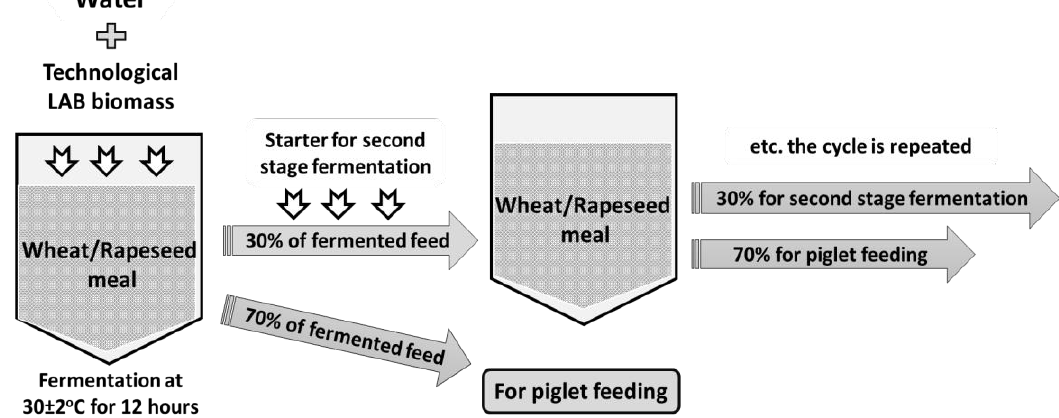
Figure 1. Scheme of fermented feed preparation. The technological lactic acid bacteria (LAB) biomass consisted of Lactobacillus plantarum LUHS122, Lactobacillus casei LUHS210, Lactobacillus farraginis LUHS206, Pediococcus acidilactici LUHS29, Lactobacillus plantarum LUHS135 and Lactobacillus uvarum LUHS245.